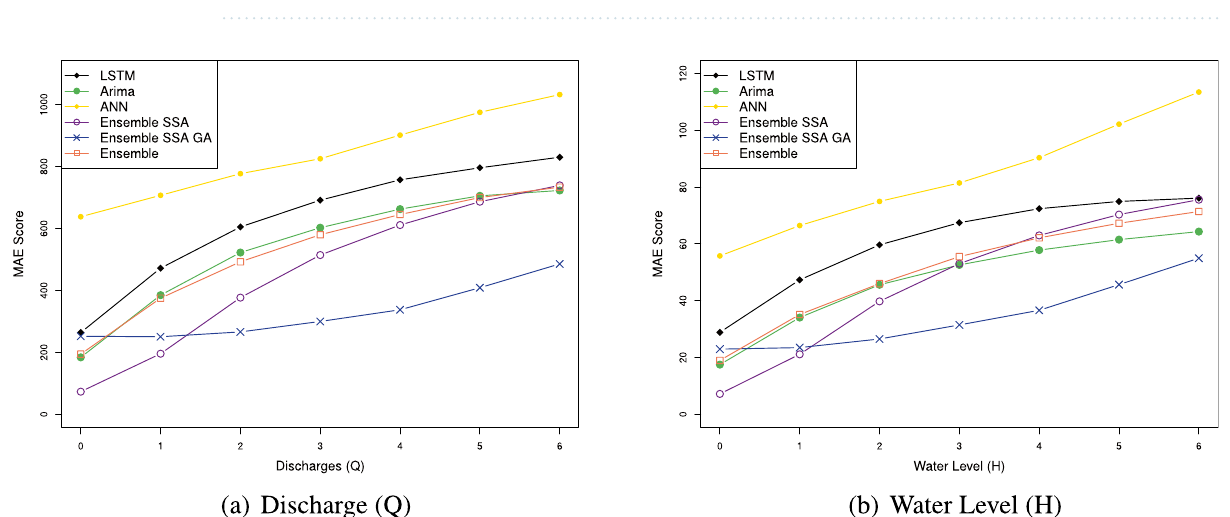
Figure 16. Multi-step-prediction MAE scores of all approaches. The MAE increases when increasing the number of output timesteps. Overall, our proposed method achieves the smallest MAE score.